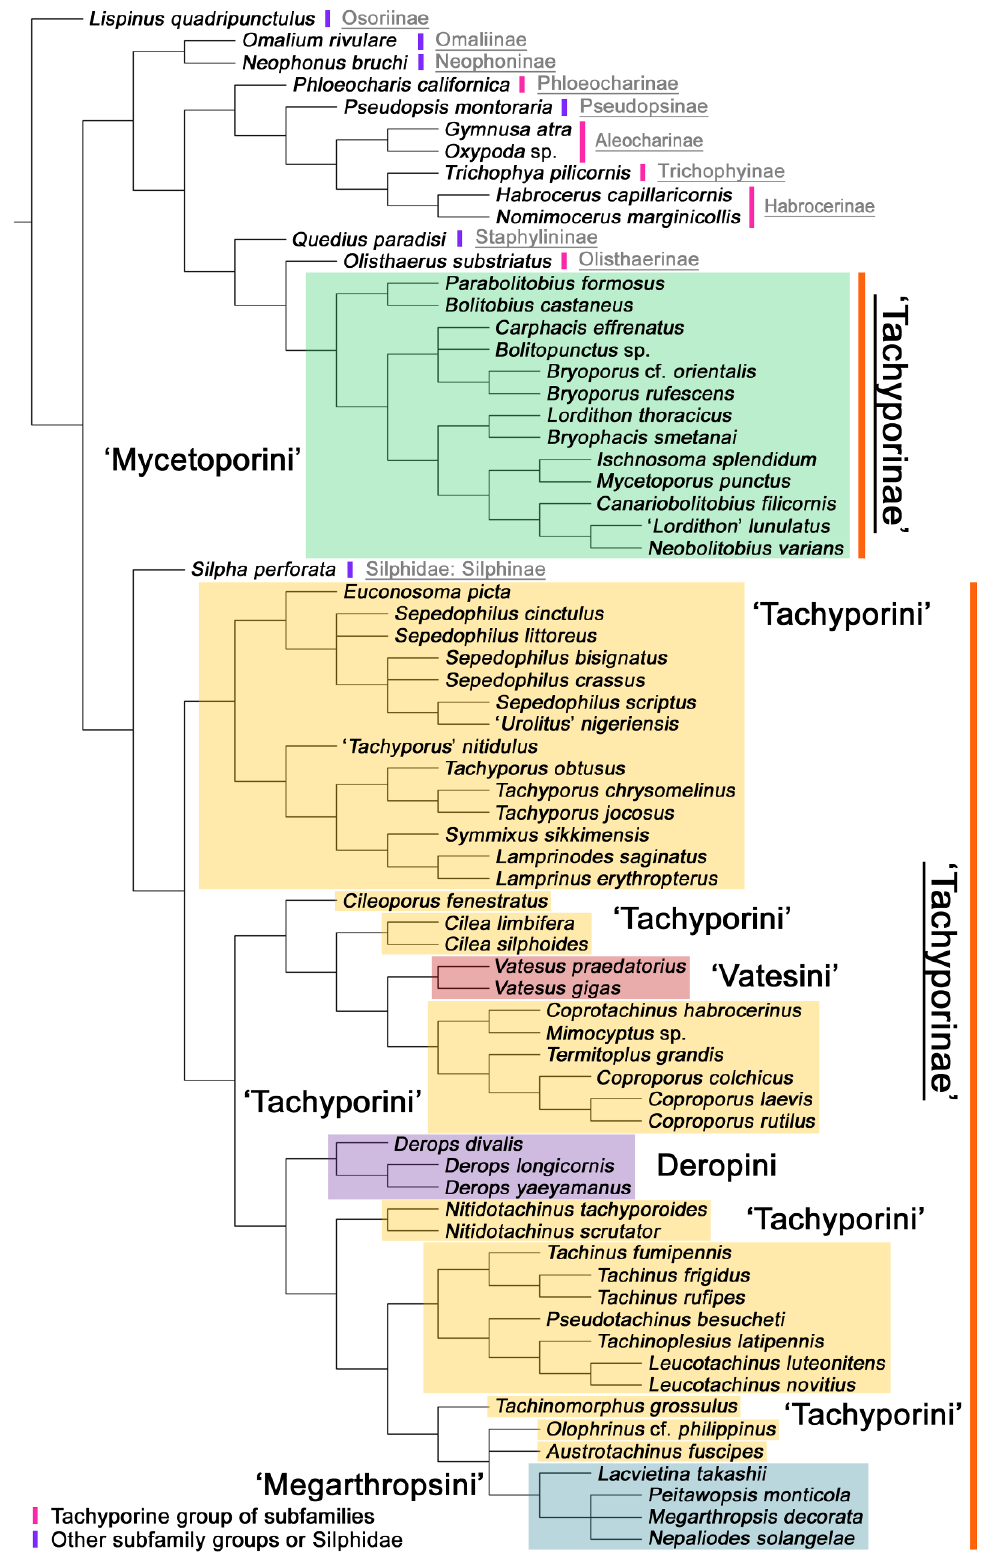
Figure 2. Results of the parsimony analysis of the phylogenetic relationships within Tachyporinae (strict consensus tree of the three obtained trees), showing non-monophyly of both Tachyporinae and Tachyporini. The family-group taxon names shown here reflect current